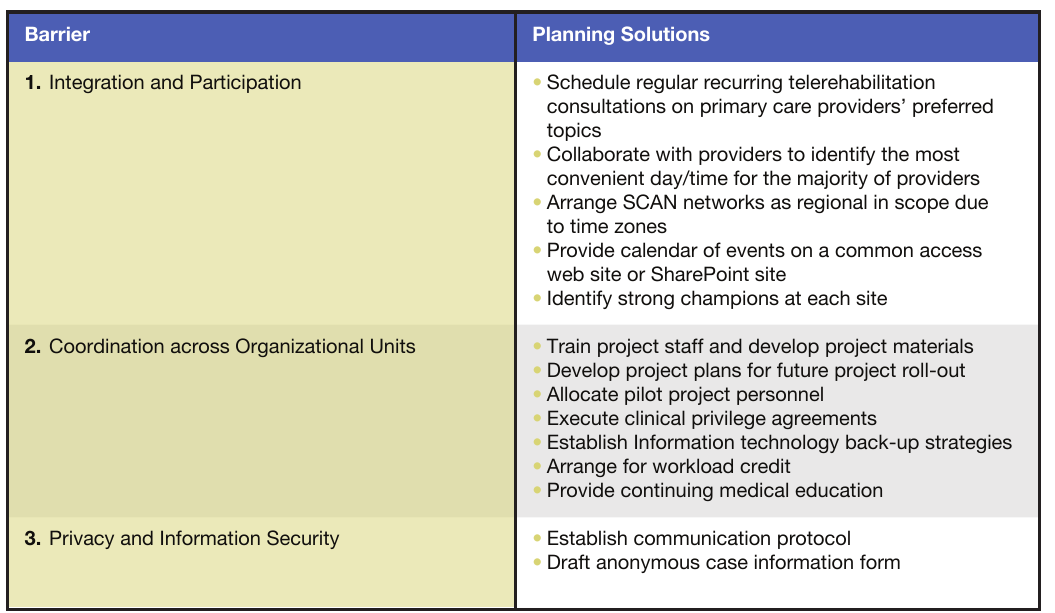
Table 3: Solutions to Barriers in Telerehabilitation